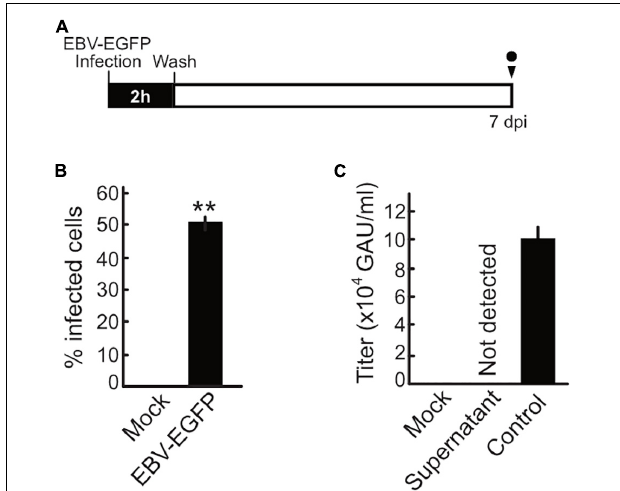
FIGURE 4 | No progeny production was detected during the pre-latent phase of EBV infection. (A) Schematic schedule of this experiment. Akata(–) cells (1 × 10 6 cells) were incubated with 1 × 10 6 GAU of EBV-EGFP at room temperature for 2 h with agitation. Cells were extensively washed with PBS to remove unbound virus and then suspended in fresh medium. Cells and culture supernatant were harvested at 7 dpi. GAU, green Akata units. (B) Infected cells were quantified by FACS. Results shown are the means ± SD of three independent experiments. Double asterisks (**) indicate p < 0.01. (C) Virus titer in the supernatant was determined as described previously (Sato et al., 2019). Results shown are the means ± SD of three independent experiments. EBV-EGFP (1 × 10 5 GAU/ml) was used as a positive